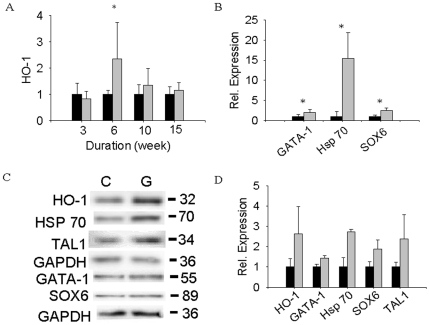
Splenic expression levels of HO-1, Hsp70, Gata-1, Sox6, and Tal1.(A) QPCR of HO-1 (mean±sd., n = 3). (B) qPCR of Gata-1, Hsp70, and Sox6 (mean±sd., n = 3). (C) Immunoblotting patterns of HO-1, Hsp70, Gata-1, Sox6 and Tal1 proteins in control (C) and garlic (G) spleen samples (week 15) with glyceraldehydes 3-phosphate dehydrogenase (GAPDH) as the reference protein. The numbers are in kilodaltons. (D) Quantification of results in C (mean±s.e.m., n = 3). Expression is calculated relative to the control samples of each time point (A) or of week 15 (B, D). The fold increase in garlic-fed samples was calculated as [ratio of (protein X/GAPDH) in garlic-fed mouse spleen]/[ratio of (protein X/GAPDH) in control mouse spleen]. (Statistics: *, p<0.05 by student's t test). Black bars, control diet; gray bars, garlic diet.